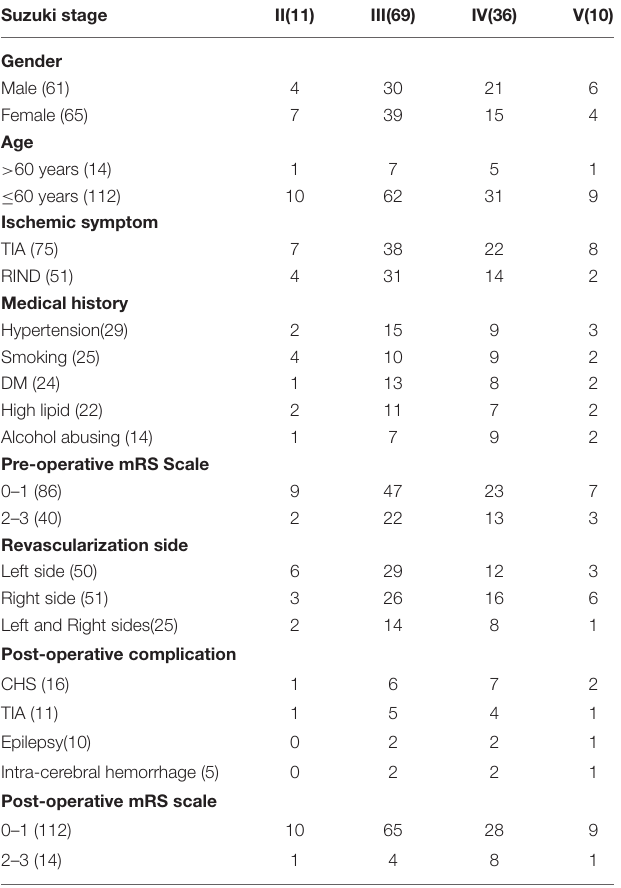
3-month follow-up (109.5 ± 16.3 ml; P > 0.05). Early- and